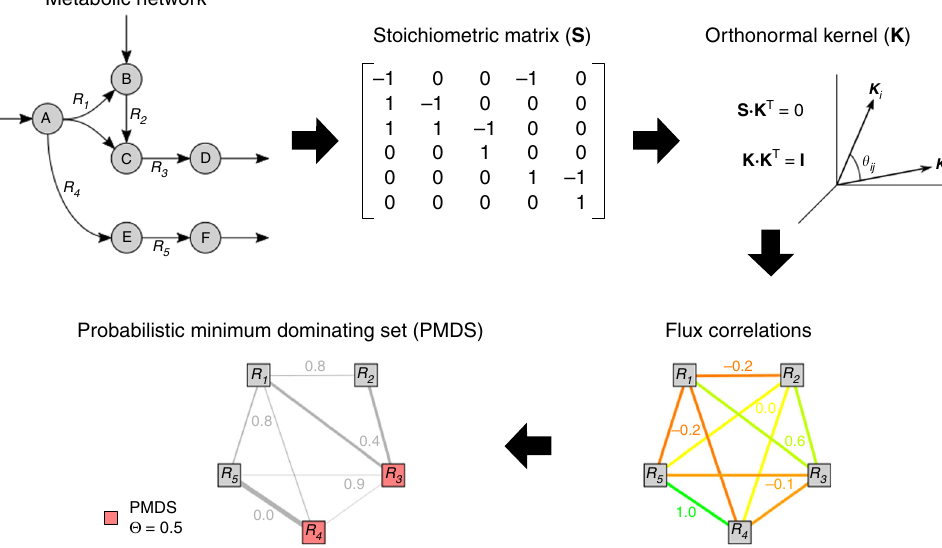
Fig. 1 Method for the application of probabilistic control theory to metabolic fl ux analysis. The stoichiometric matrix of the metabolic network is constructed and used to compute the orthonormal kernel matrix. The reaction correlation coef fi cient ϕ ij is the cosine of the angle between the reaction rows in the kernel and represents the strength of control between both reactions. The failure probability ρ ij is de fi ned as 1 − | ϕ ij |, which is used to determine the probabilistic minimum dominating set. We require that each node (reaction) is covered by multiple nodes in PMDS so that the probability that at least one edge (incoming fl ux) is active is greater than the threshold